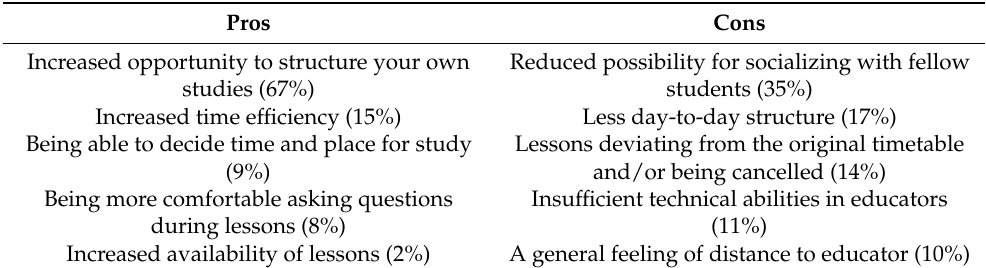
Table 3. Five most common answers when students were asked about the pros and cons of digital